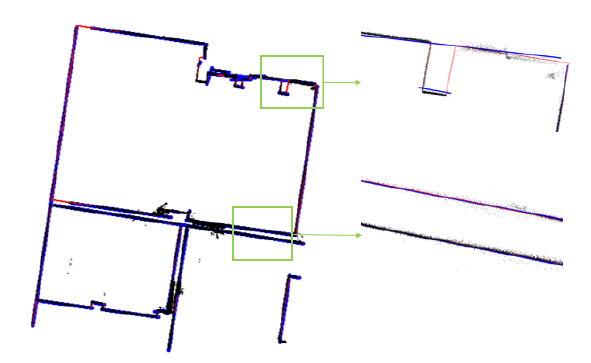
Figure 10. Comparison of the ground truth wall segments (red) and the extracted segments by the proposed algorithm (blue).